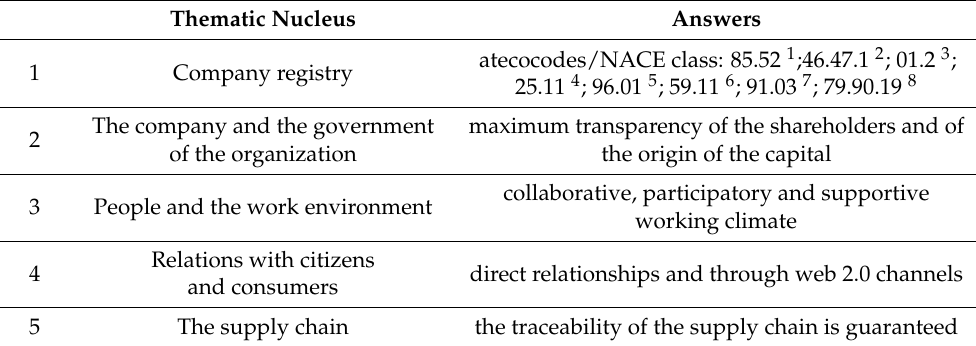
Table 4. The seven macro areas of investigation for